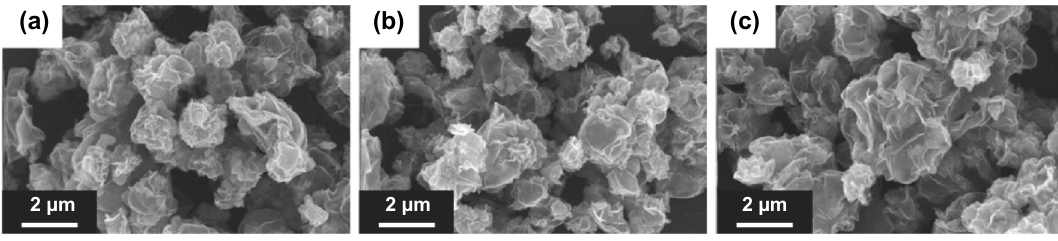
Fig. 3 FE‑SEM of the KTO NP/PGC composites prepared at different weight ratios (GO:KOH:TiO 2 ) of a 1:1:0.25, b 1:2:0.25, and c 1:3:0.25 (reaction temperature: 200 °C, gas flow rate: 10 L min −1 , post‑heat treatment: 700 °C, 2